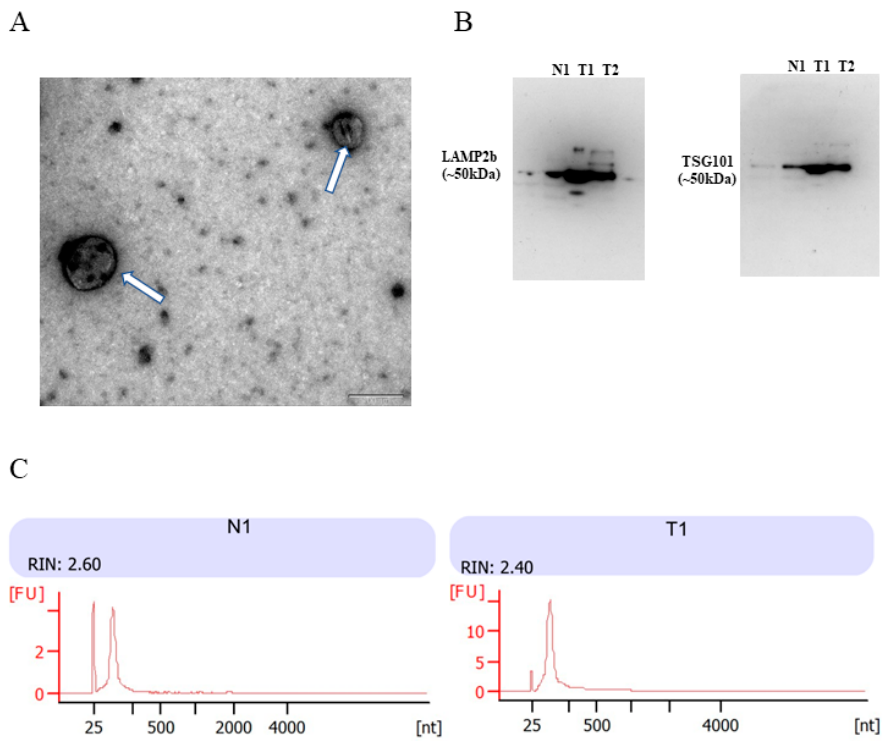
Figure 1 . Characterization of EVs from urine samples. ( A ) Isolated particles were analyzed using TEM, which showed the typical size and morphology. Typical EVs were highlighted using white arrows. Solid black lines represent 100 nm scale bars; ( B ) Western blot analysis of urinary EVs with antibodies LAMP2b and TSG101 from one healthy control (N1) and two PCa patients (T1 and T2); ( C ) the RNA size distribution of urinary EVs from one healthy control (N1) and one PCa patient (T1) was analyzed by bioanalyzer